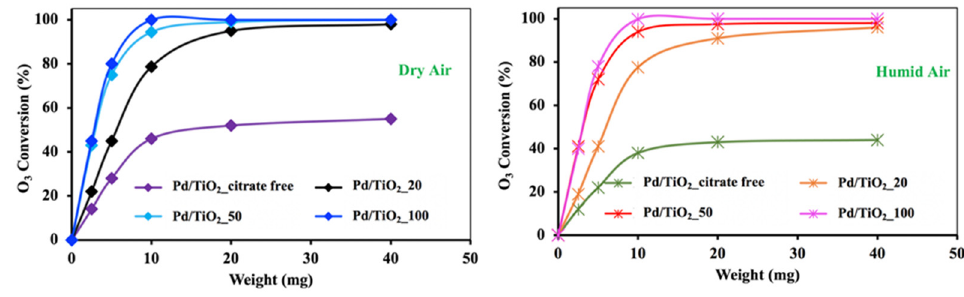
Figure 8. Effect of catalyst mass on ozone conversion for Pd/TiO 2 _x (x = 20, 50, 100) and Pd/TiO 2 _citrate free catalysts. (Experimental conditions: m = 2.5; 5; 10; 20 and 40 mg, O 3 = 15 ppm, H 2 O = 3130 ppm (corresponding to RH = 10%), flow rate = 1000 mL min − 1 , T = 25 °C).